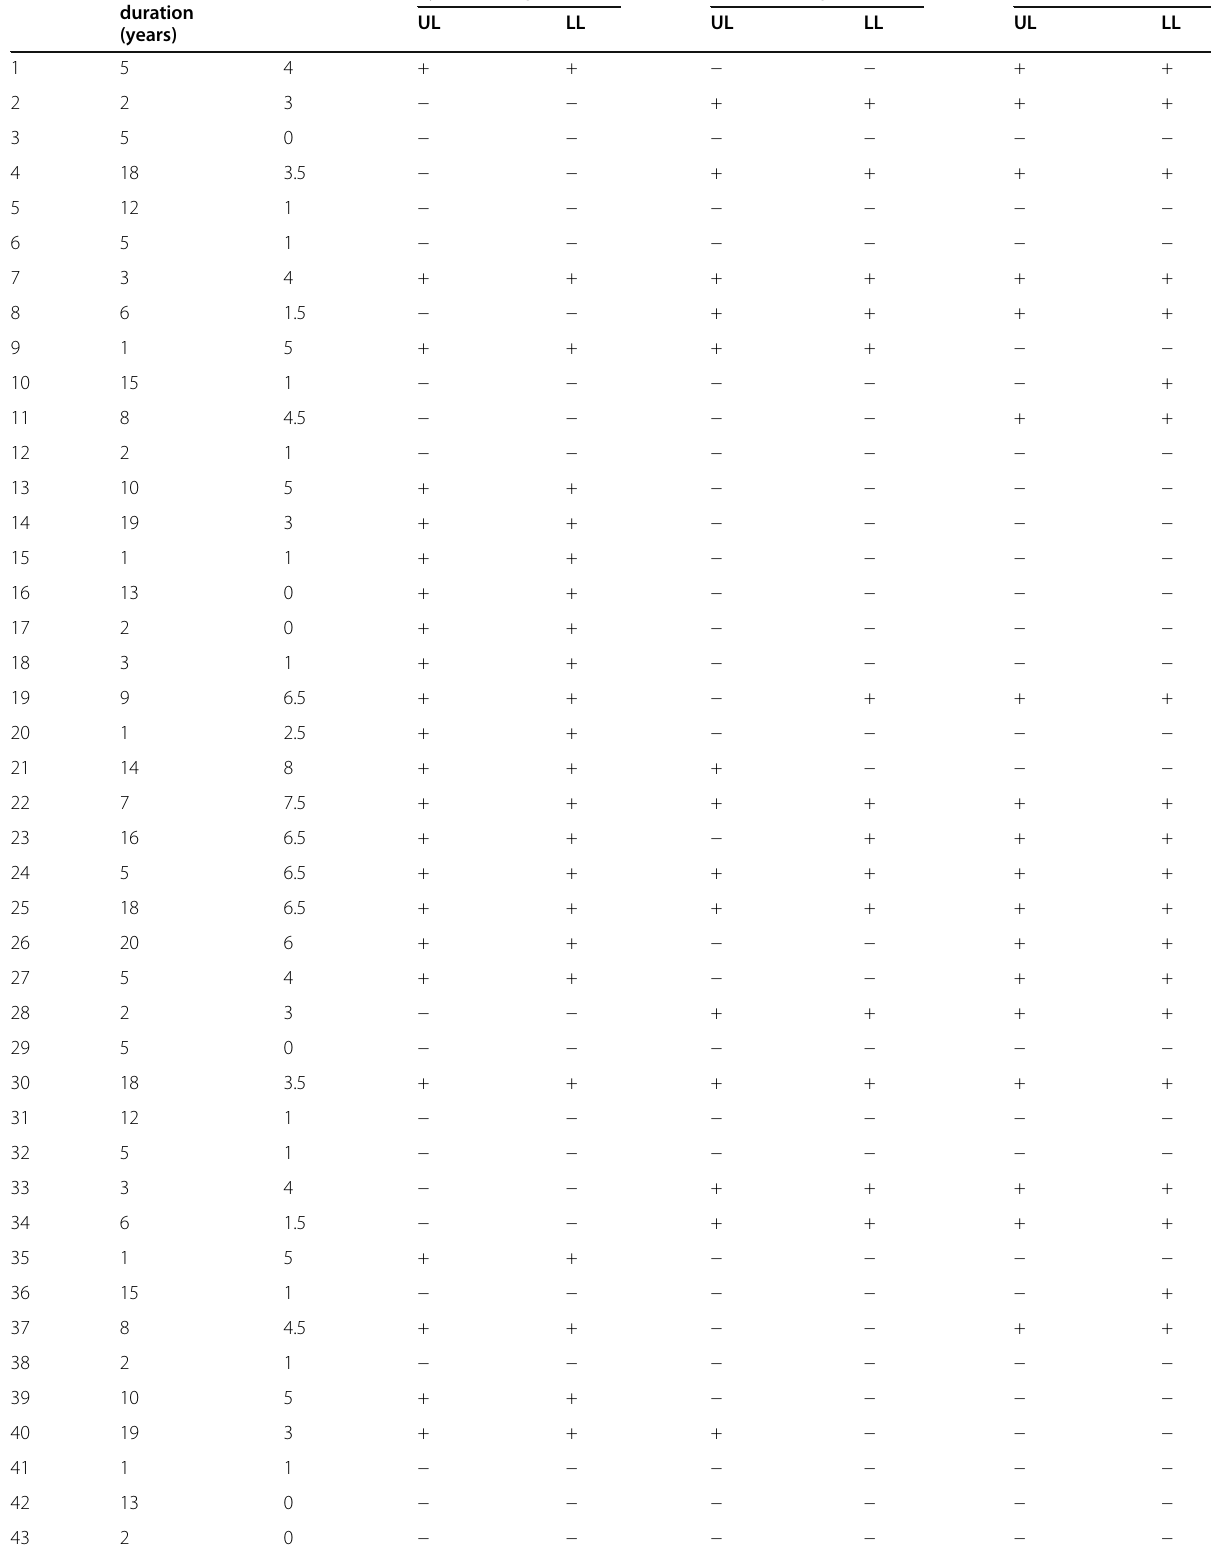
Table 1 Baseline clinical data of patients with multiple